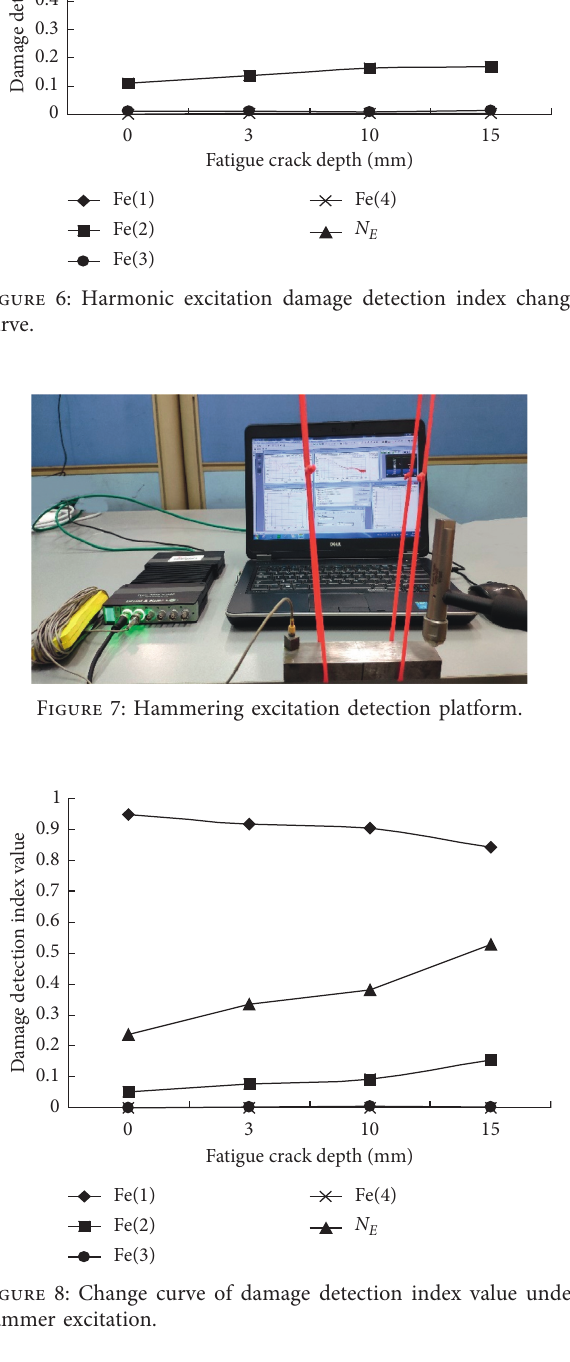
Figure 9: The sample of pillar porcelain insulator.